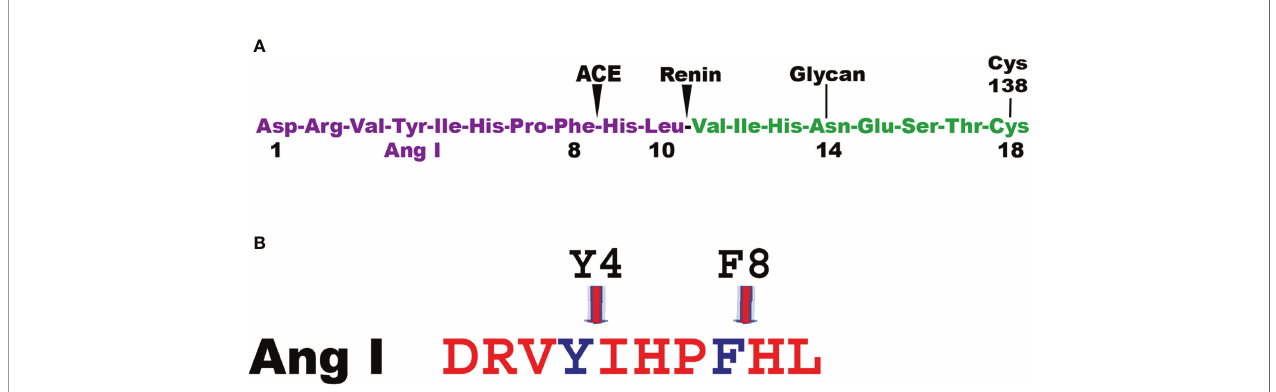
FIGURE 3 | Angiotensin cleavage. Panel A shows the N-terminal end of angiotensinogen including the 10 amino acid and the cleavage sites in angiotensinogen for renin and for the angiotensin converting enzyme (ACE). Panel B shows the Ang I peptide with the cleavage site for the majority of MC chymase at Phe 8